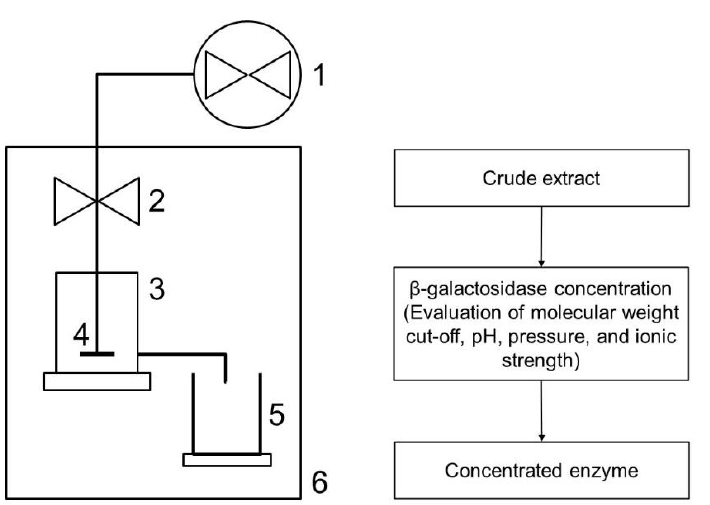
Figure 1. Scheme of the UF system used for β -galactosidase concentration: (1) nitrogen cylinder with valve; (2) pressure control; (3) ultrafiltration cell; (4) stirrer; (5) collector; (6) refrigeration.